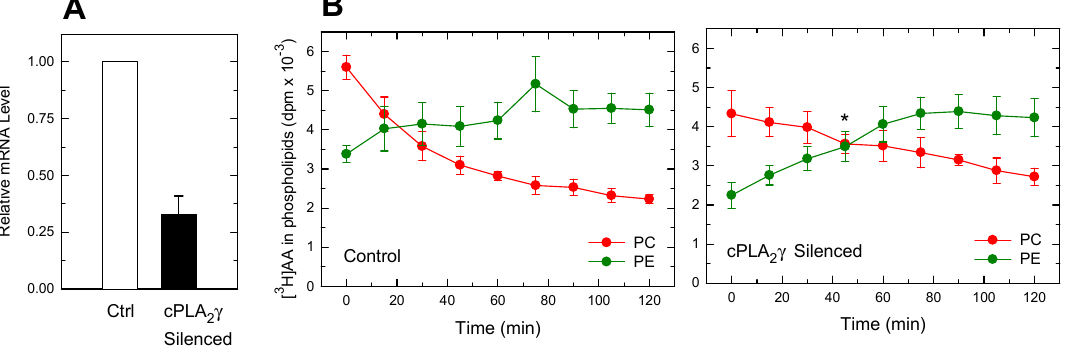
Figure 7. cPLA 2 γ role in phospholipid AA remodeling: ( A ) PCR analysis of cPLA 2 γ expression in RAW 264.7 cells. ( B ) Phospholipid AA remodeling was analyzed in cells treated with a scrambled siRNA (Control) or siRNA targeting cPLA 2 γ (cPLA 2 γ Silenced). Results are shown as means ± S.E.M. (n = 5). The asterisk in the Figure 7B right panel denotes that the remodeling time of cPLA 2 γ -silenced cells is significantly different from that of control cells (* p < 0.05).